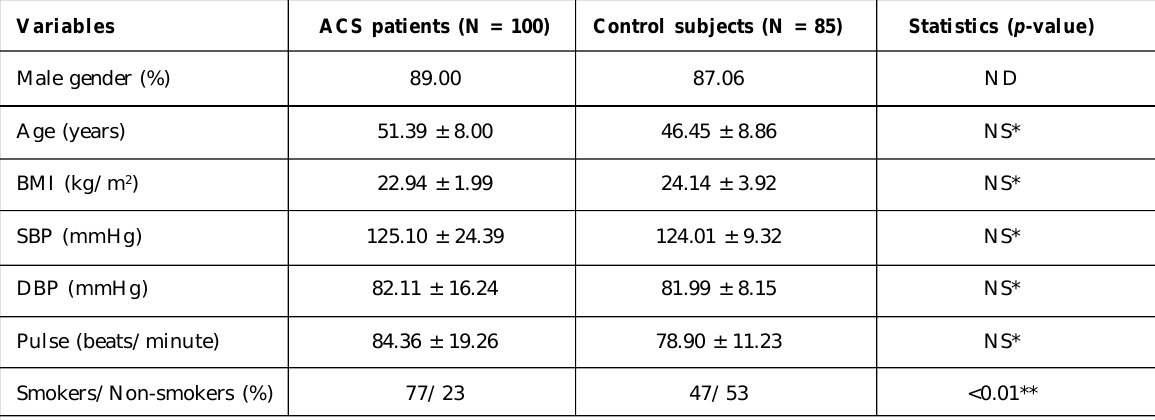
Table 1: Baseline characteristics of the ACS patients and control subjects Variables ACS patients (N = 100) Control subjects (N = 85)